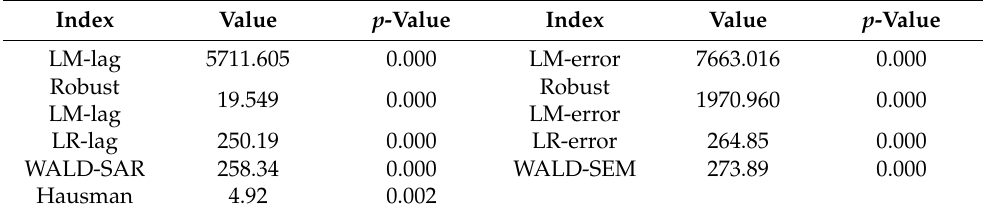
Table 11. Spatial econometric model